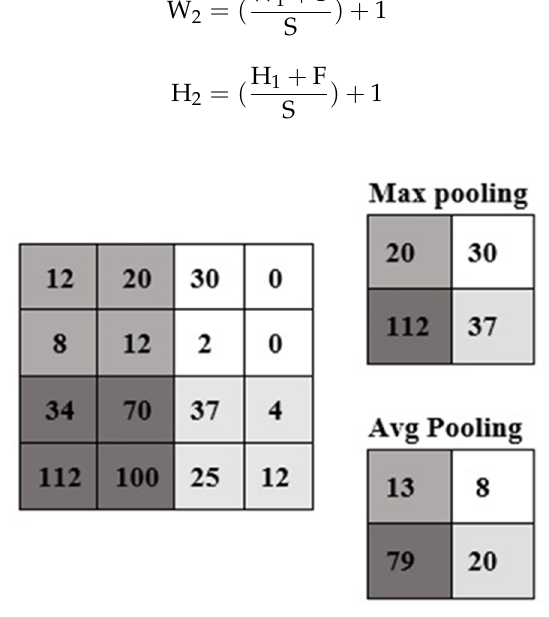
Figure 1. Examples of max and average pooling.